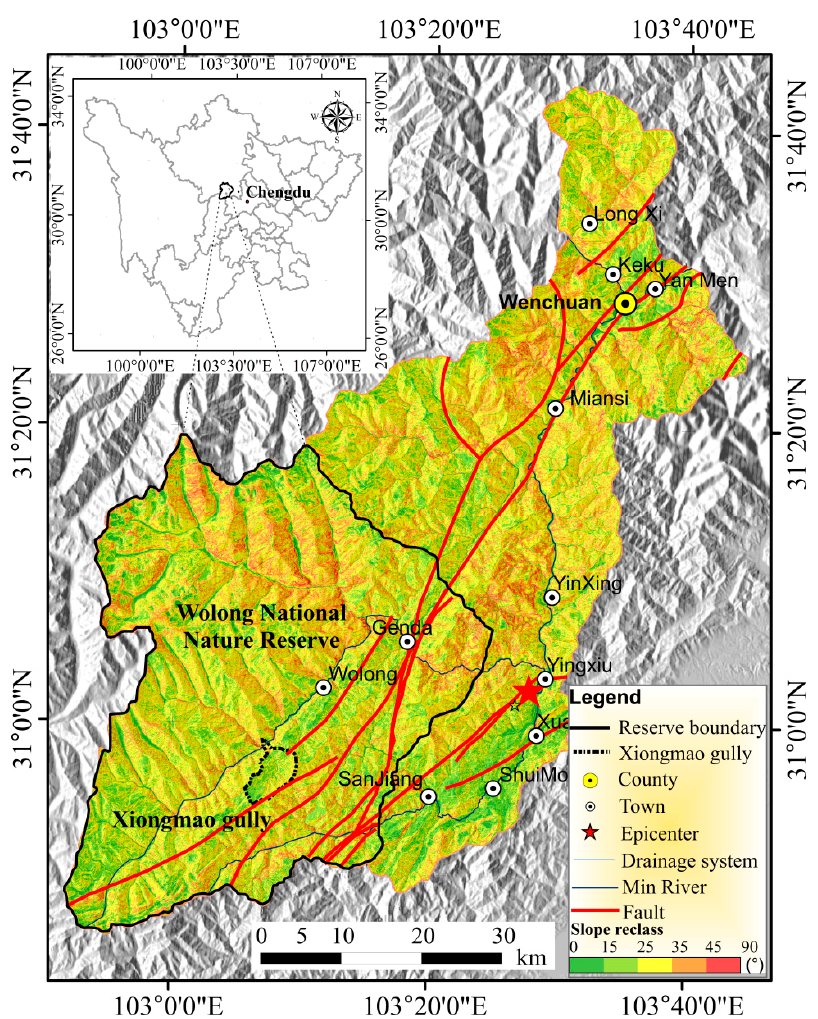
Figure 1. Map of Xiongmao Gully, located in Wolong National Nature Panda Reserve. Xiongmao Gully, located in the Wolong nature reserves, southwest of Wolong, Wenchuan County, Sichuan Province, is the primary tributary on the right bank of Yuzi river. The average longitudinal length of the gully is 8.8km, average width is 3.4 km, average longitudinal grade is 169.9% (cid:24) , and the catchment area is 23.6 km 2 . Additionally, the highest elevation located at the southwest outlet of the gully is 3600 m; the lowest one at the junction between the outlet and Yuzi River is 2105 m. The upstream catchment contains six branches with lengths from 0.9 to 2.4 km and longitudinal gradients from 15% to 35% (Figures 1 and